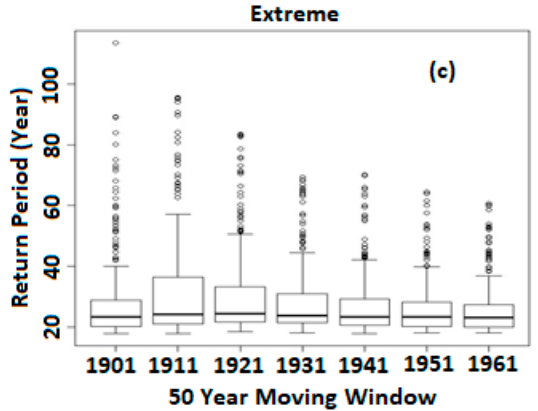
Figure 6. Box-plots showing the return periods of ( a ) moderate, ( b ) severe, and ( c ) extreme meteorological droughts during wheat-growing season observed for different 50-year windows over 1901–2010.